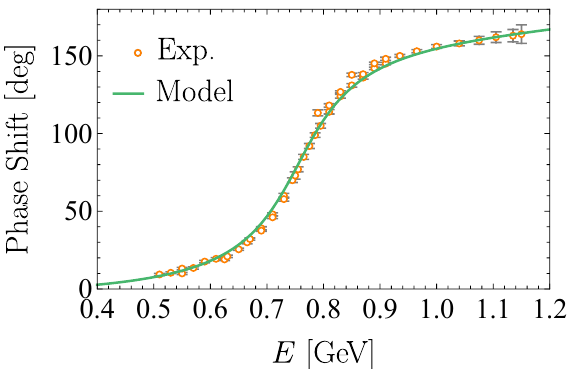
Figure 11 . P-wave ππ phase shifts of the phenomenological model defined in eq. (6.8) (solid line) in comparison with the experimental data from refs. [69, 70] (open dots).